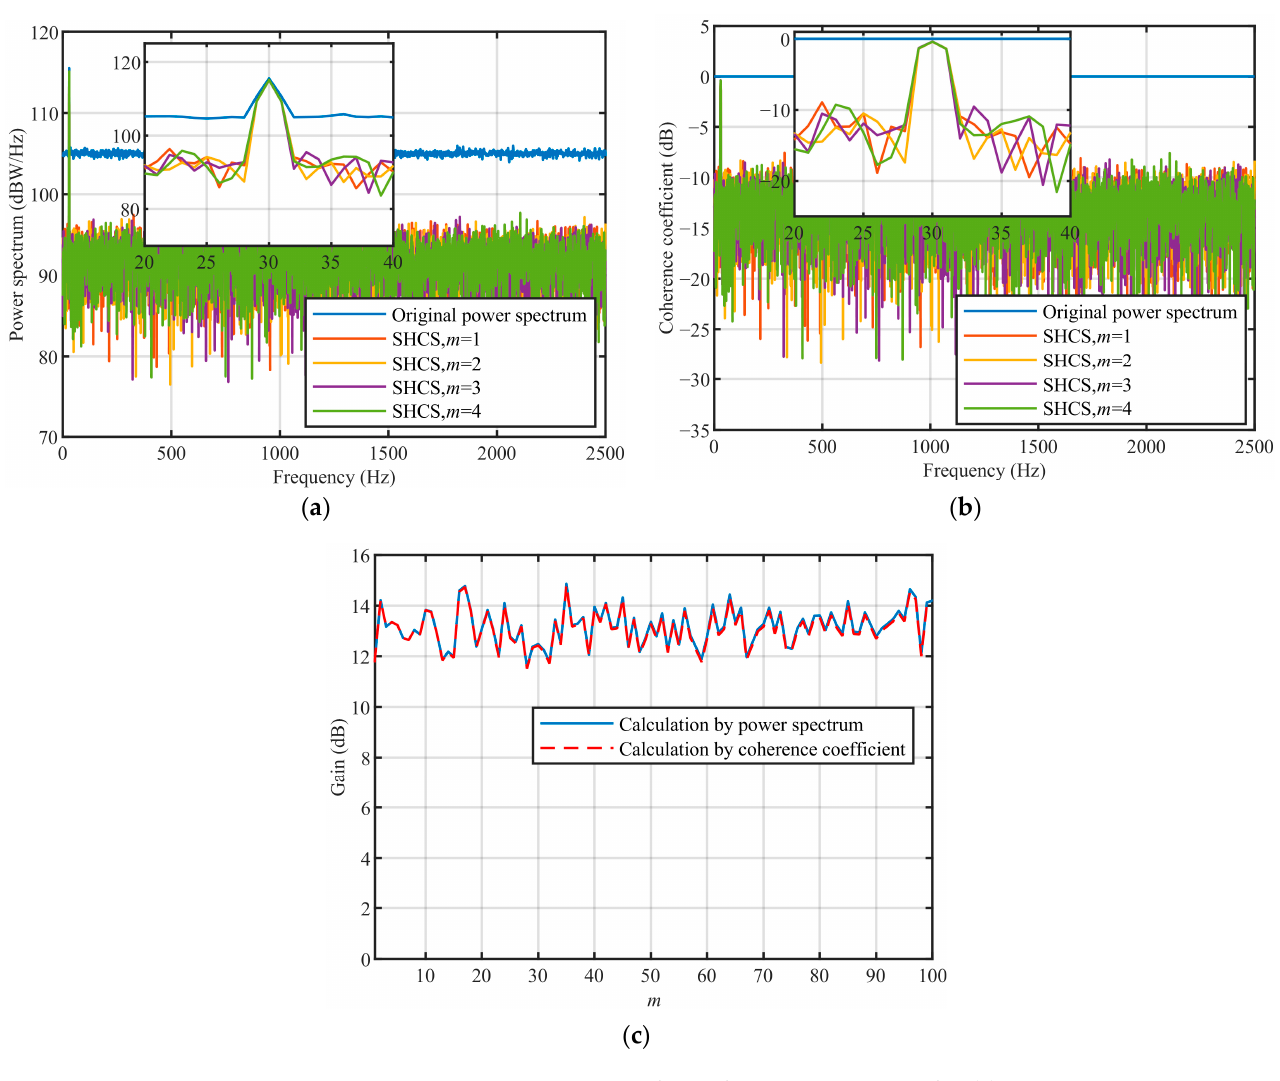
Figure 2. SHCS processing results with input SNR = 10 dB: ( a ) power ‐ spectrum estimation (re 0.67 × 10 − 18 W/Hz); ( b ) coherence ‐ coefficient calculation results; ( c ) gain.